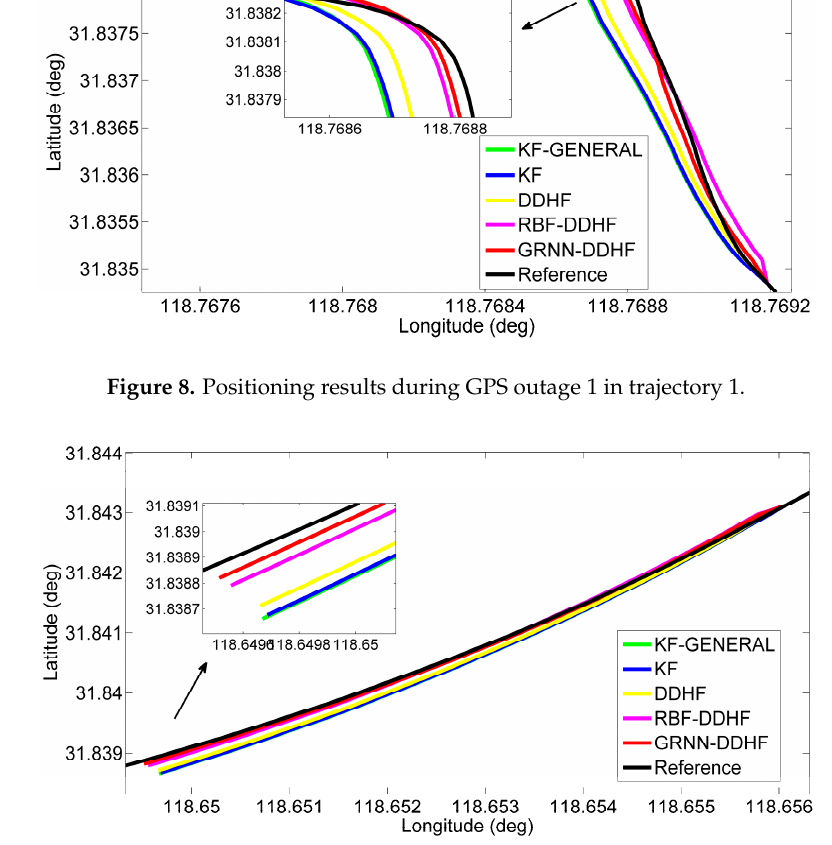
Figure 9. Positioning results during GPS outage 5 in trajectory 1.